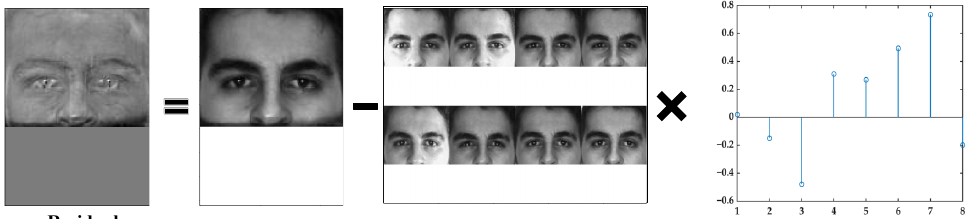
Figure 8. Residual calculation of arrangement scheme a (scarves occluding the face). [Reprinted with permission from Elsevier [20]. Copyright 2013, Neurocomputing].